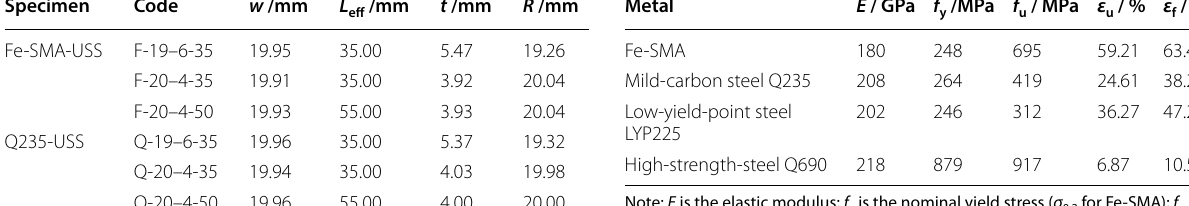
Table 1 Measured geometrical dimensions of the USS specimens Specimen